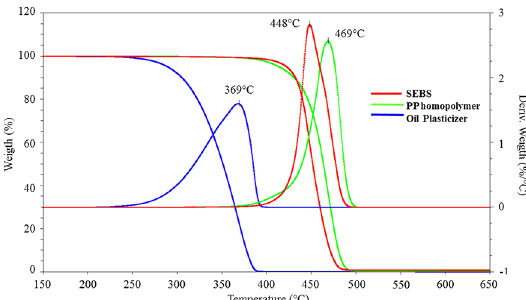
Figure 1. TGA and DTG curves of the individual components.